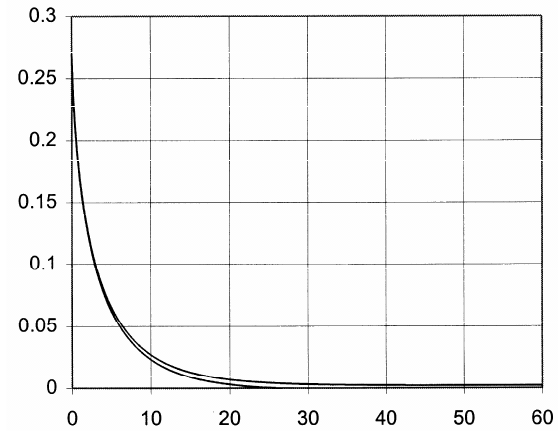
Figure 3 – Inverse Gaussian, with mean 1, variance 5, (cid:84) =2.5 and (cid:71) =ln(1+0.05), using (cid:39)